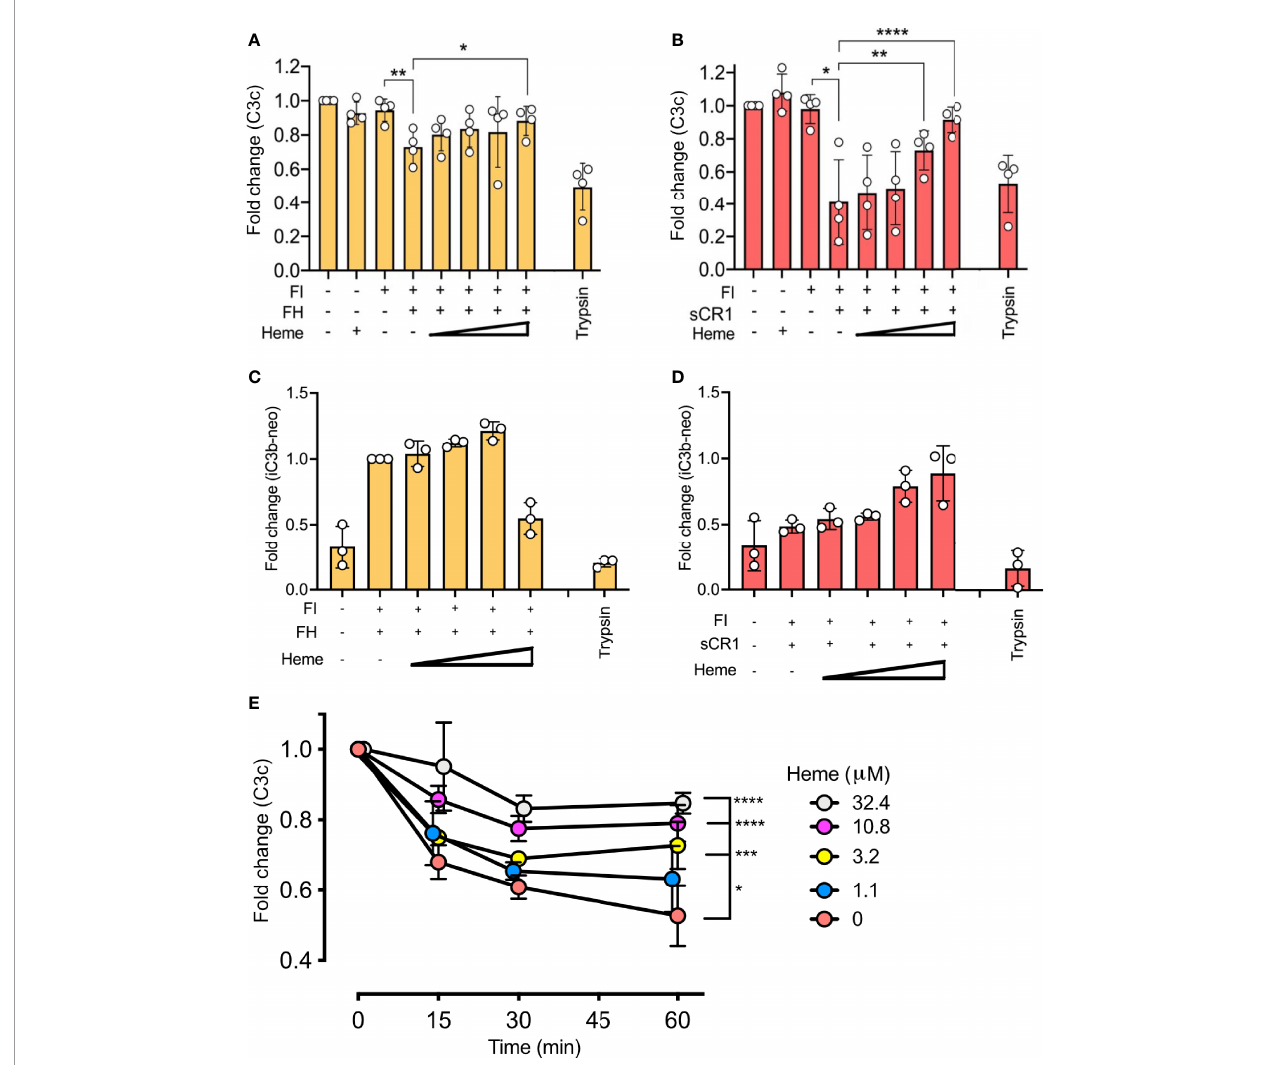
FIGURE 3 | Effect of heme on factor I (FI)-mediated degradation of surface-bound C3b. C3b, covalently connected bound to magnetic beads, were analyzed for factor I (FI-mediated degradation by (A – D) puri fi ed components in phosphate buffered saline (PBS) and (E) lepirudin plasma at 37°C. Degradation of C3b was analyzed by a polyclonal anti-C3c antibody (A, B, E) , and a monoclonal iC3b antibody (C, D) . (A – D) Factor I (FI, 0.1 m g) and (A, C) factor H (FH, 0.1 m g) or (B, D) soluble complement receptor 1 (sCR1, 0.1 m g) were incubated with C3b-beads at 37° C for 60 minutes in PBS pH 7.4. Heme was supplemented in increasing amounts (1.1, 3.2, 10.8, 32.4 m M). Trypsin was included as a positive control. Values are shown as the mean of three independent experiments +/- standard deviation. Paired t-tests were used to compare C3b-beads and FI with and without co-factor. (E) One-way ANOVA non-parametric test was used for the comparison between C3b-beads with FI and co-factor with various concentrations of heme. (E) C3b-beads were incubated in lepirudin-plasma supplemented with compstatin Cp40 (8 m M) and heme in concentrations from 0 – 32.4 m M for 15, 30, or 60 minutes at 37°C. The graph shows mean +/- standard deviation from three independent experiments, all normalized to the mean fl uorescent intensity (MFI) of beads at the start of incubation. One-way ANOVA non-parametric test was used for the comparison between C3b-beads with heme versus C3b-beads with various concentrations of heme. *p < 0.05, **p < 0.01, ***p < 0.001, ****p <